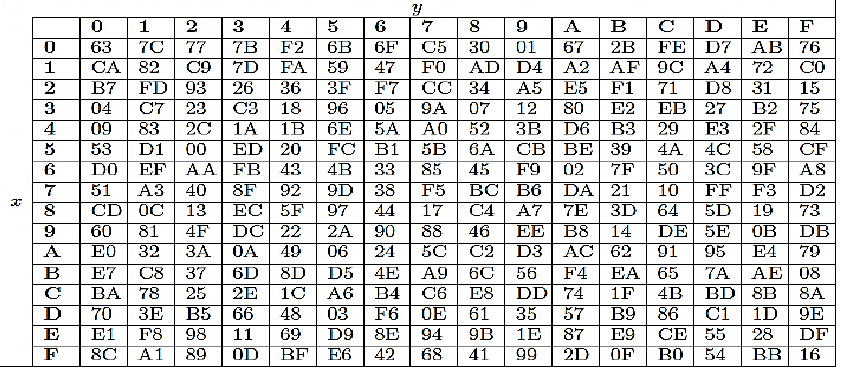
Figure 1. Schematic representation of the Advanced Encryption Standard (AES) encryption algorithm.